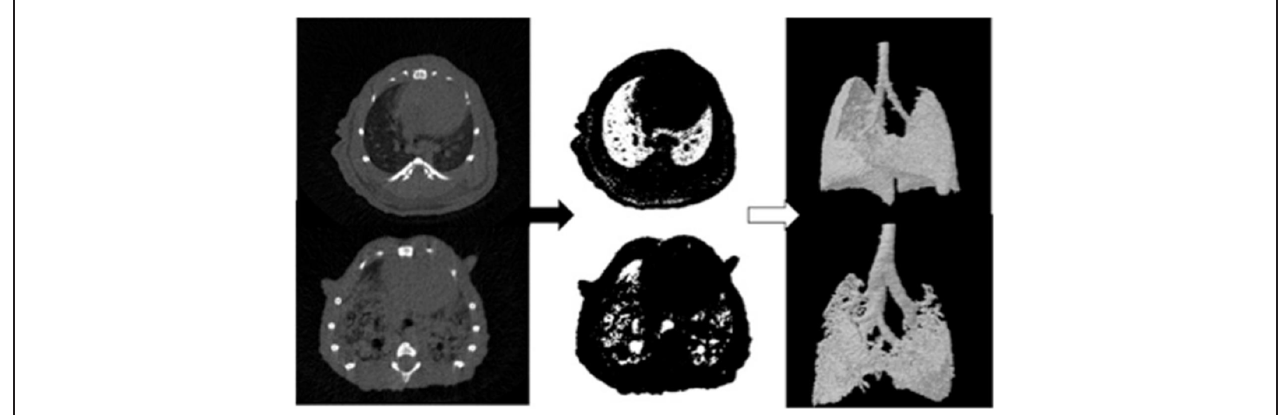
FIGURE 4 | Automated analysis of lung air volumes for a normal mouse and a mouse with lung fibrosis. CT cross-sections of the lungs are thresholded to include only those voxels which primarily contain air. These binary images are then converted to 3D volumes to visualize and quantify the aerated lung volumes. The fibrotic lung has significantly reduced air volume compared to the normal lung. Reprinted from (De Langhe et al., 2012) under the Creative Commons Attribution License.